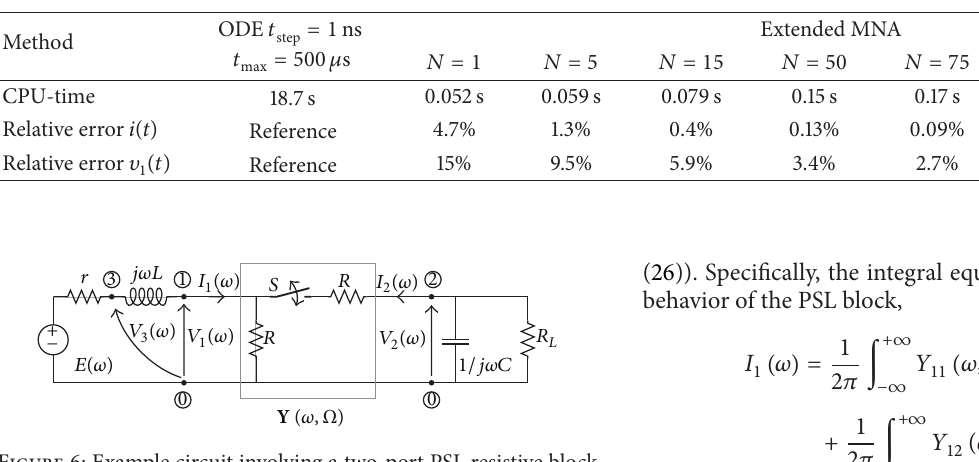
Figure 6: Example circuit involving a two-port PSL resistive block and standard (both resistive and dynamical) LTI elements. The values of components are 𝑟 = 10Ω , 𝐿 = 1 mH, 𝑅 = 100 Ω , = 100 Ω , and 𝐶 = 1𝜇 F. The switch operates as in the first 𝑅 𝐿 example of Figure 3. The independent DC voltage source 𝑒(𝑡) = 𝑡) V is defined in frequency-domain as 𝐸(𝜔) = 10 + 2 sin (𝜔 0 ) − 𝛿(𝜔 + 𝜔 )) V, where 𝜔 = 2𝜋𝑓 10/(2𝜋) 𝛿 (𝜔) + 1/𝑗𝜋 (𝛿 (𝜔 − 𝜔 0 0 0 0 and 𝑓 0 = 40